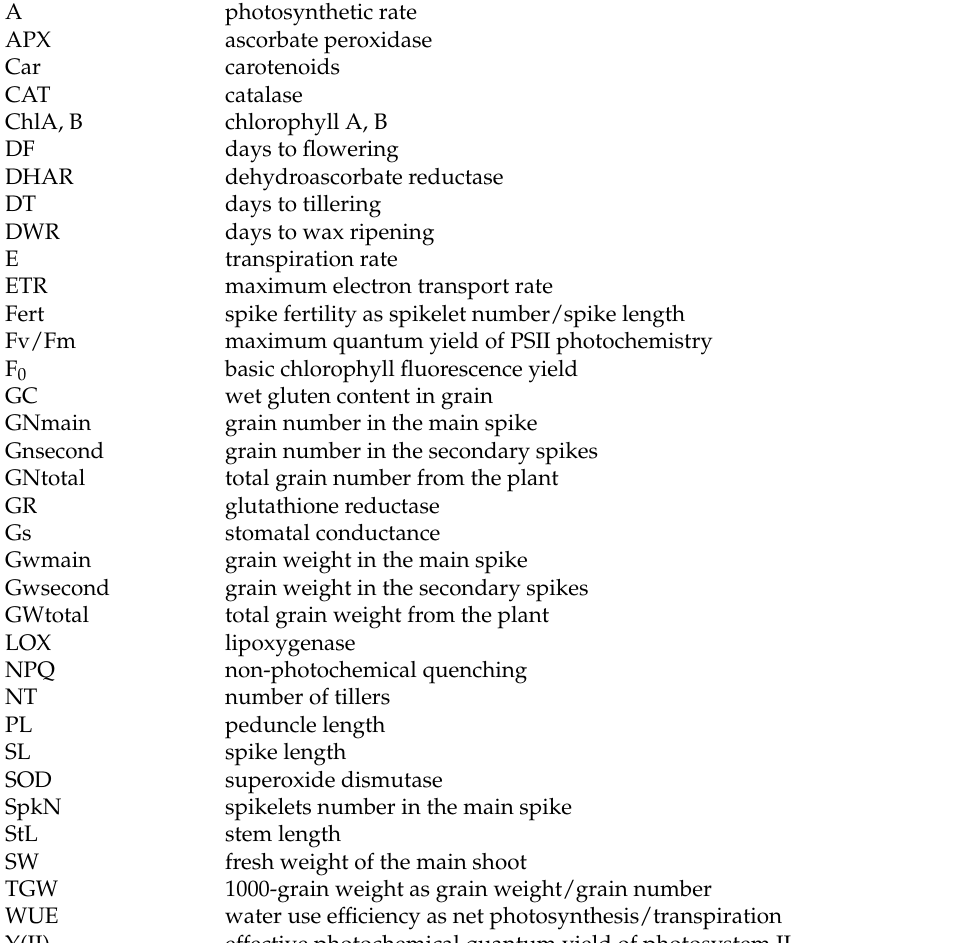
Table A1. List of abbreviations.